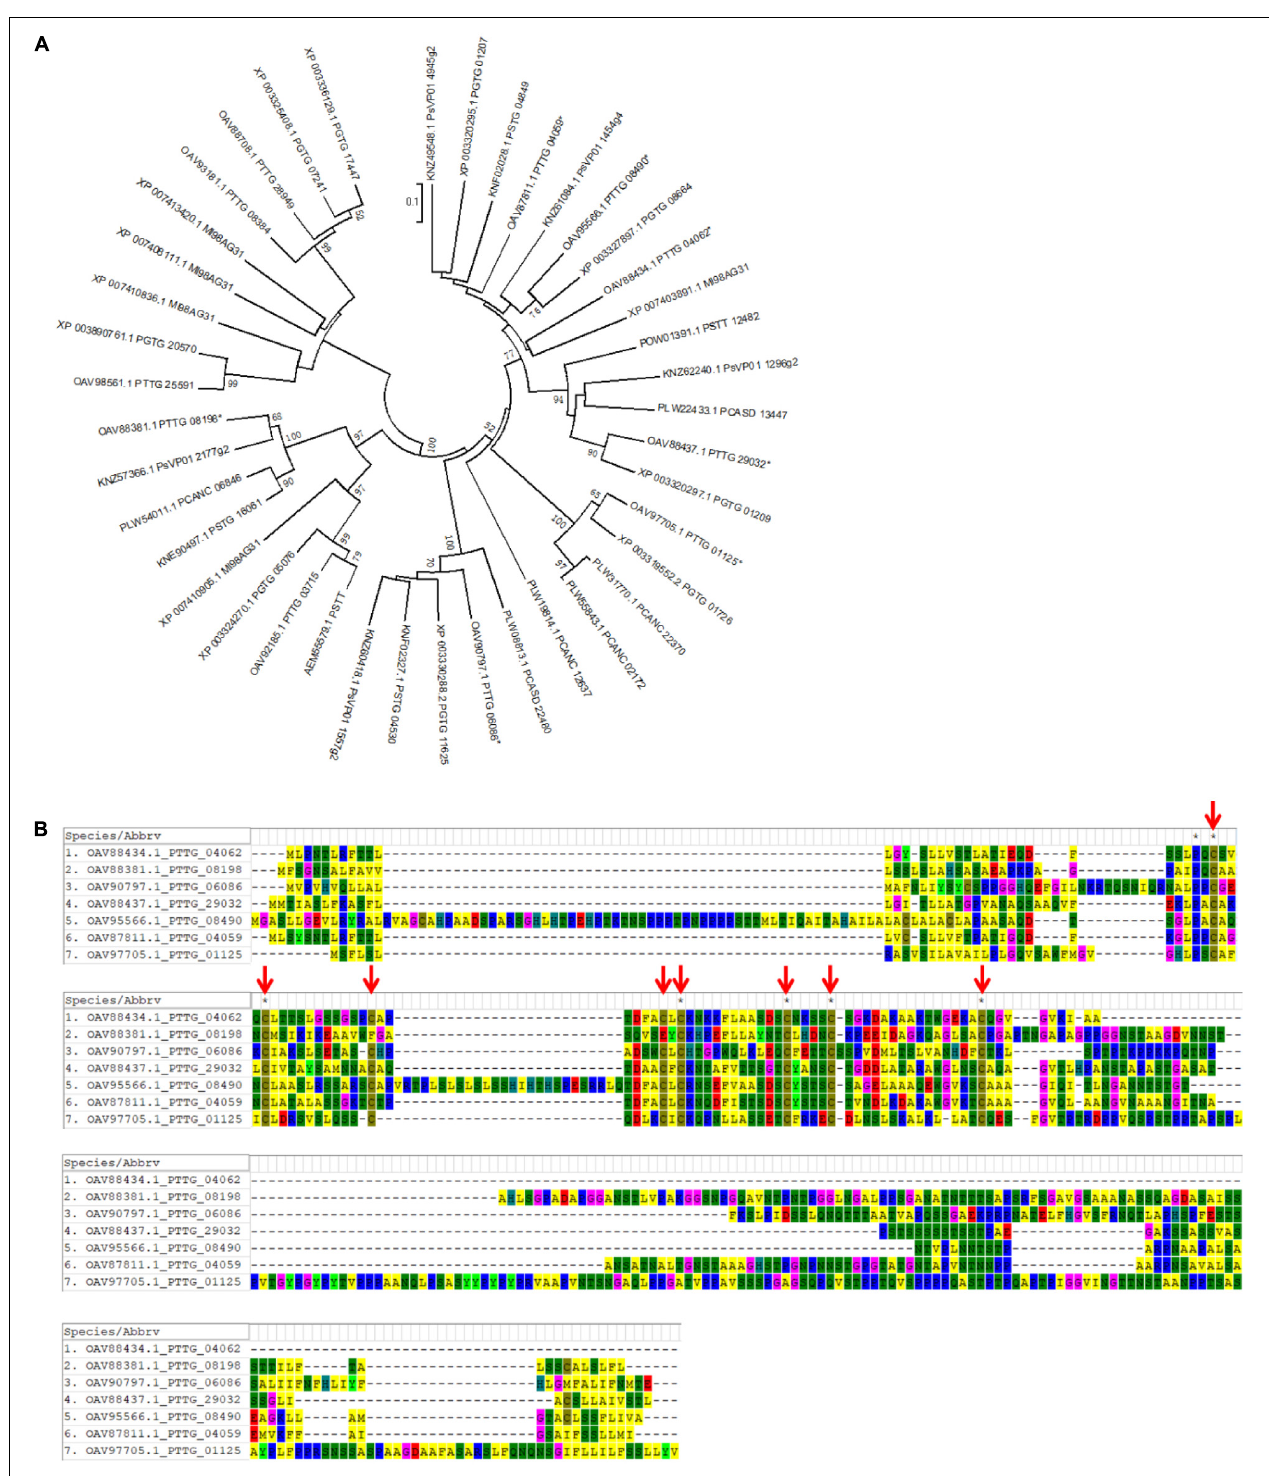
FIGURE 5 | Identification of wheat leaf rust effector candidates with CFEM motif. Using HMM feature and homology analysis, nine secreted proteins with CFEM motif were identified from the wheat leaf rust fungus. (A) A phylogenetic tree of PtCFEM effector candidates and their closest homologs from related rust species was generated by MEGA software. Seven genes selected for further cloning and functional characterization are labeled with asterisks (*). (B) Protein sequences of the seven PtCFEM effector candidates were aligned using MUSCLE method. Conserved Cysteine residues are indicated with red arrows.